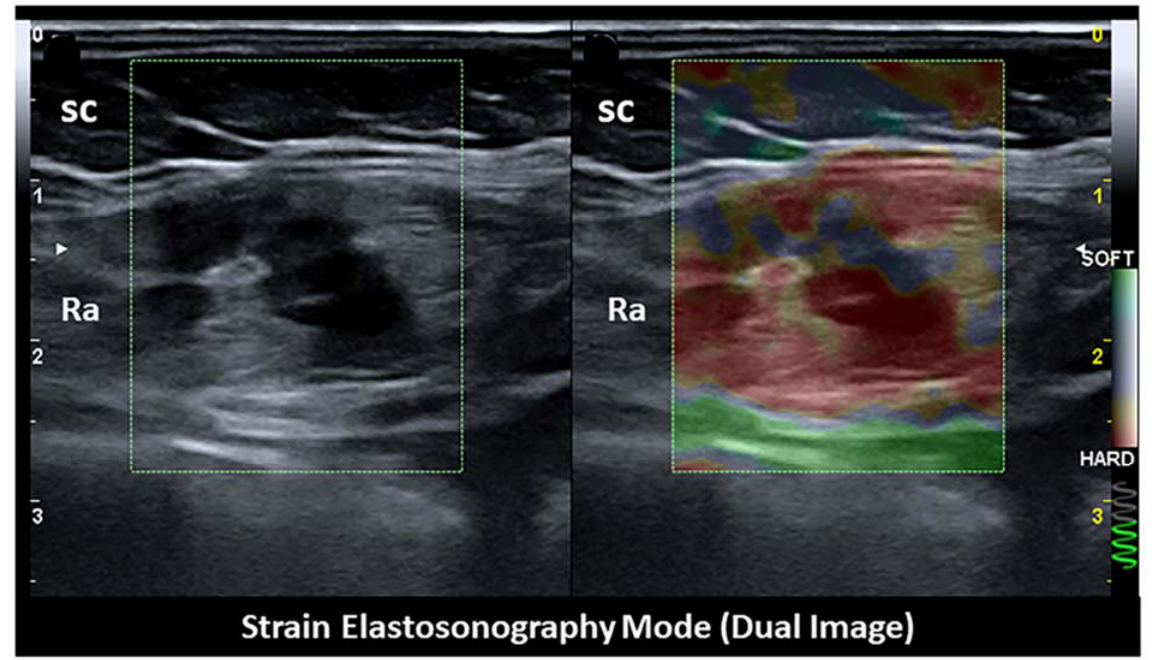
Figure 8. Strain elastosonography mode revealing the hard pattern of the endometriotic nodule. sc: subcutaneous tissue. ra: rectus abdominis muscle.